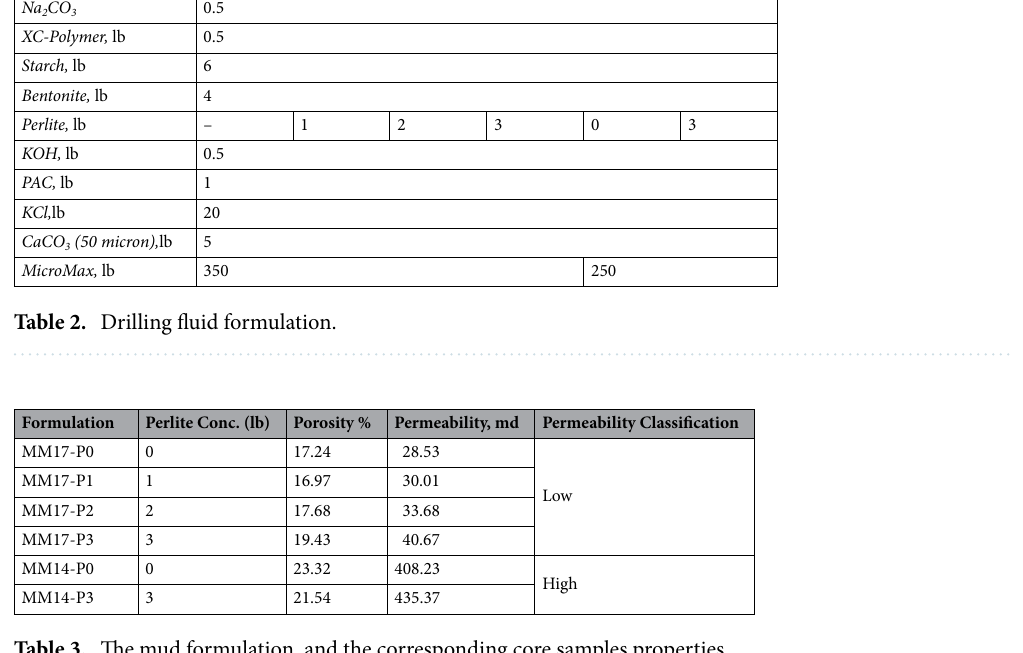
Table 3. The mud formulation, and the corresponding core samples properties.